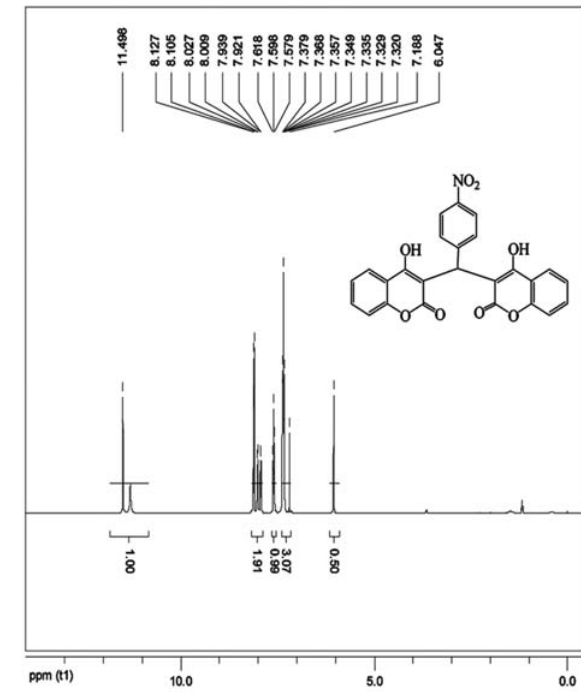
Figure 6. Magnetization curves for Fe poly(AMPS- co -AA) @ Fe